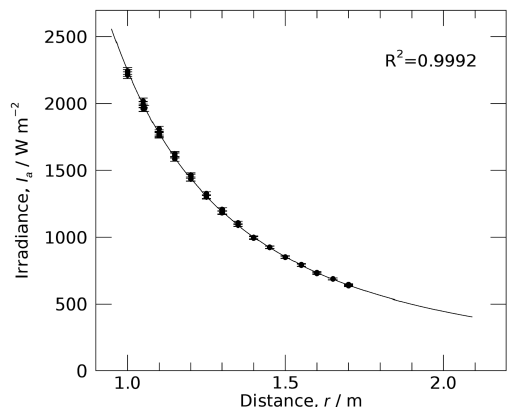
Figure 5. Measured irradiance as function of the working distance from the lamp housing. The straight curve denotes a fit according to the quadratic decrease in the irradiance (Eq. 2).